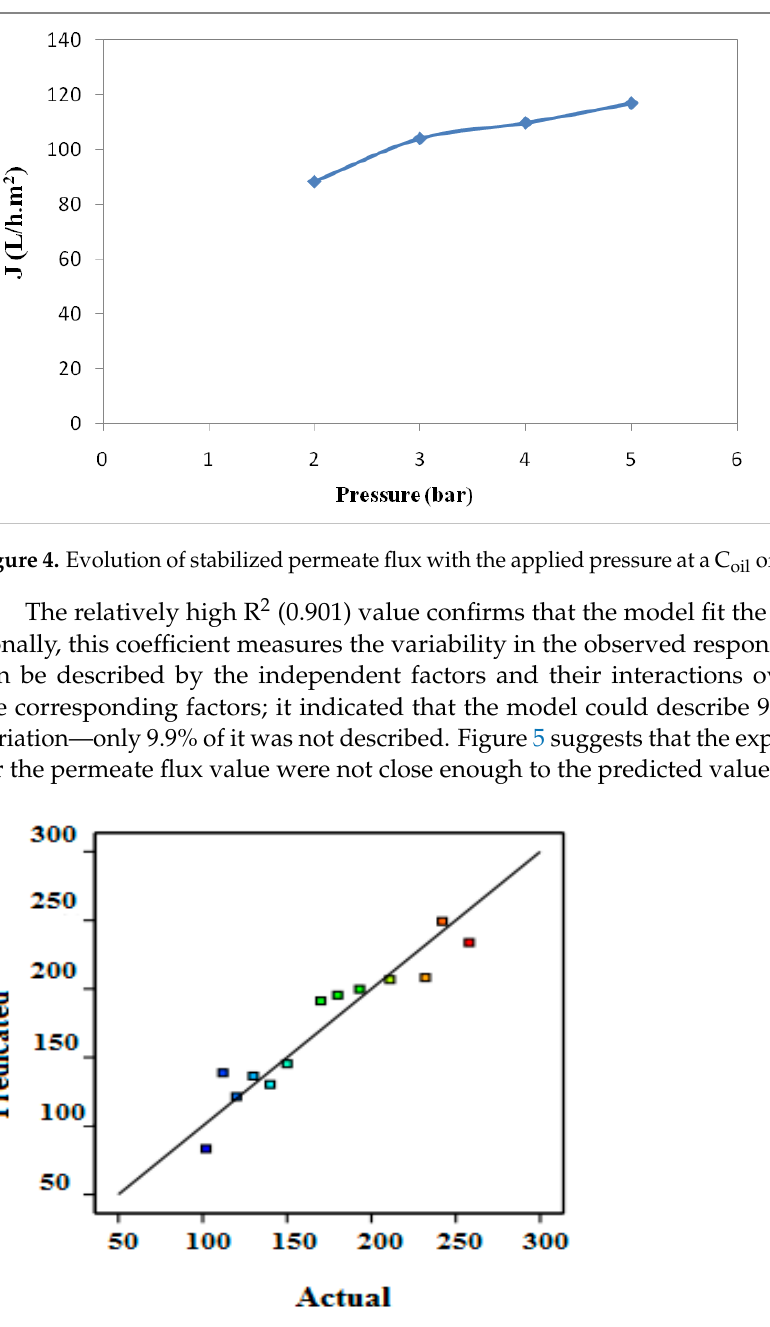
Figure 5. Comparison of the calculated and predicted values for permeate flux by RSM.